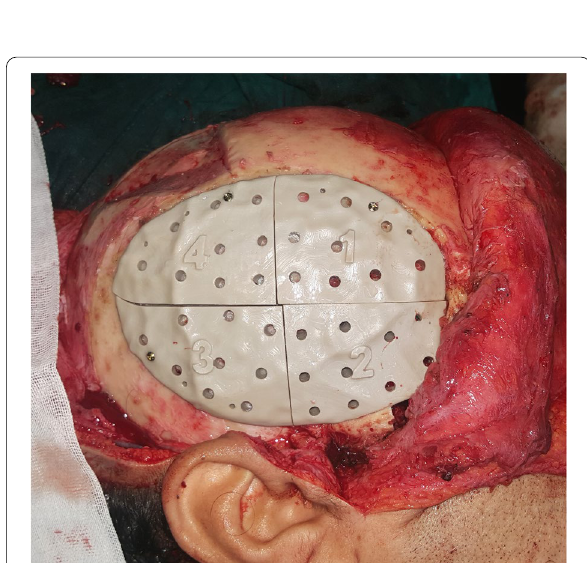
Fig. 7 The PEEK implant fixed in